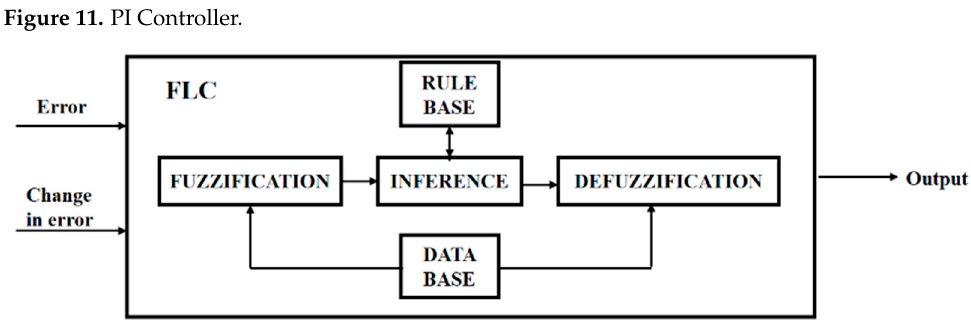
Figure 12. Block diagram representation of FLC.